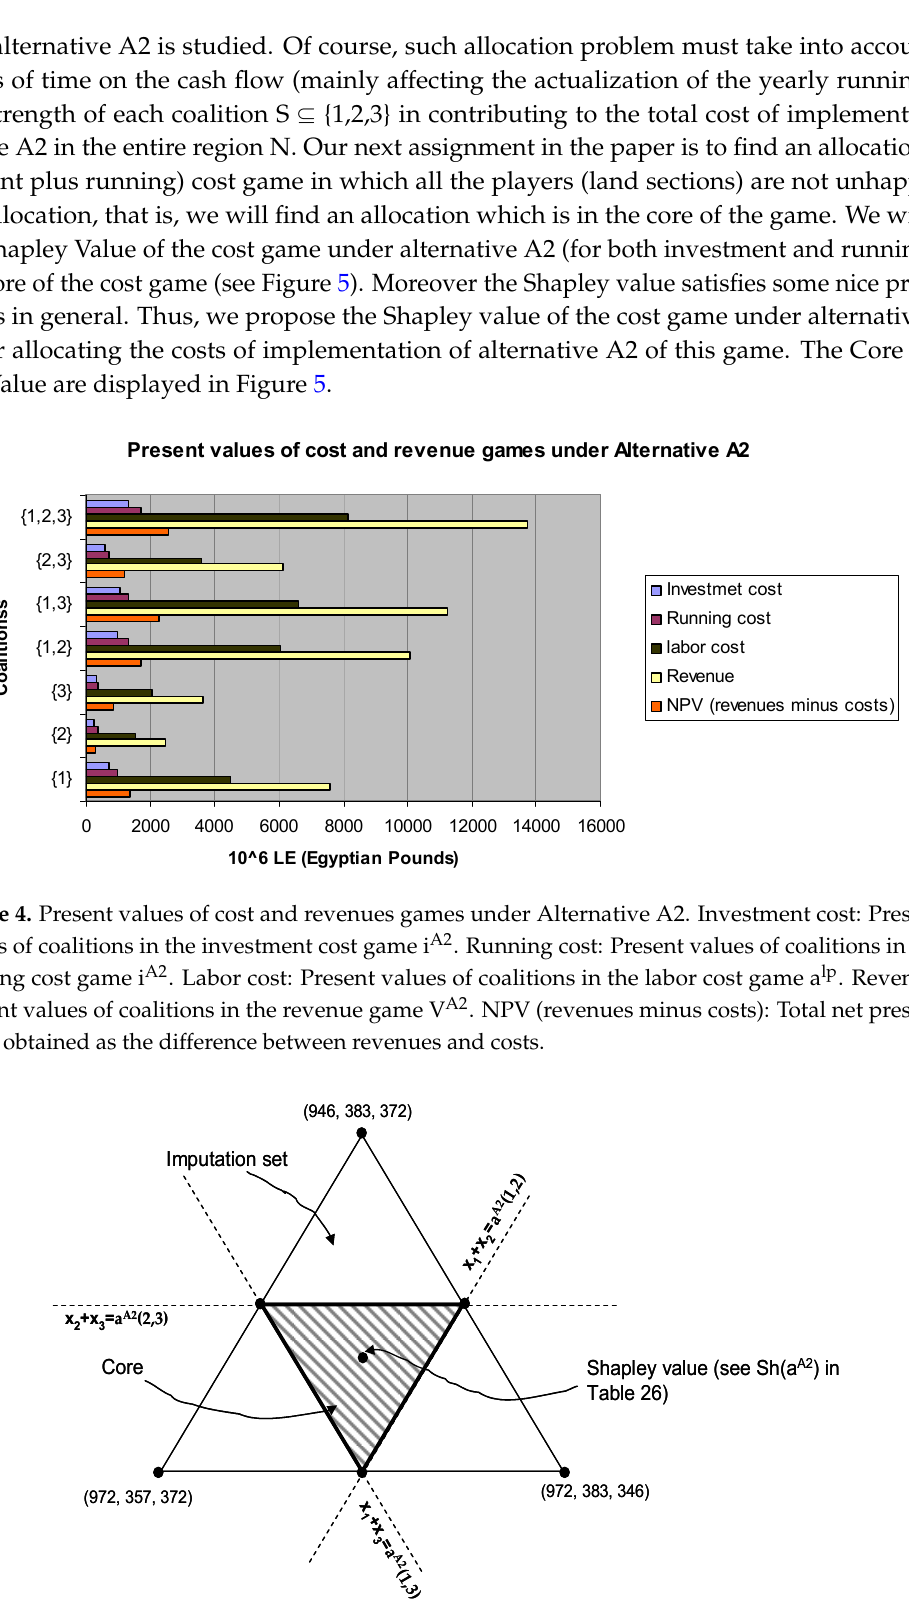
Figure 5. The Core and the Shapley Value of the cost game a A2 . Note: Vectors of numbers in the format (×1, ×2, ×3) represent the allocation for players 1, 2 and 3, respectively. Values of game a A2 in Table 25 are rounded to the nearest integer.